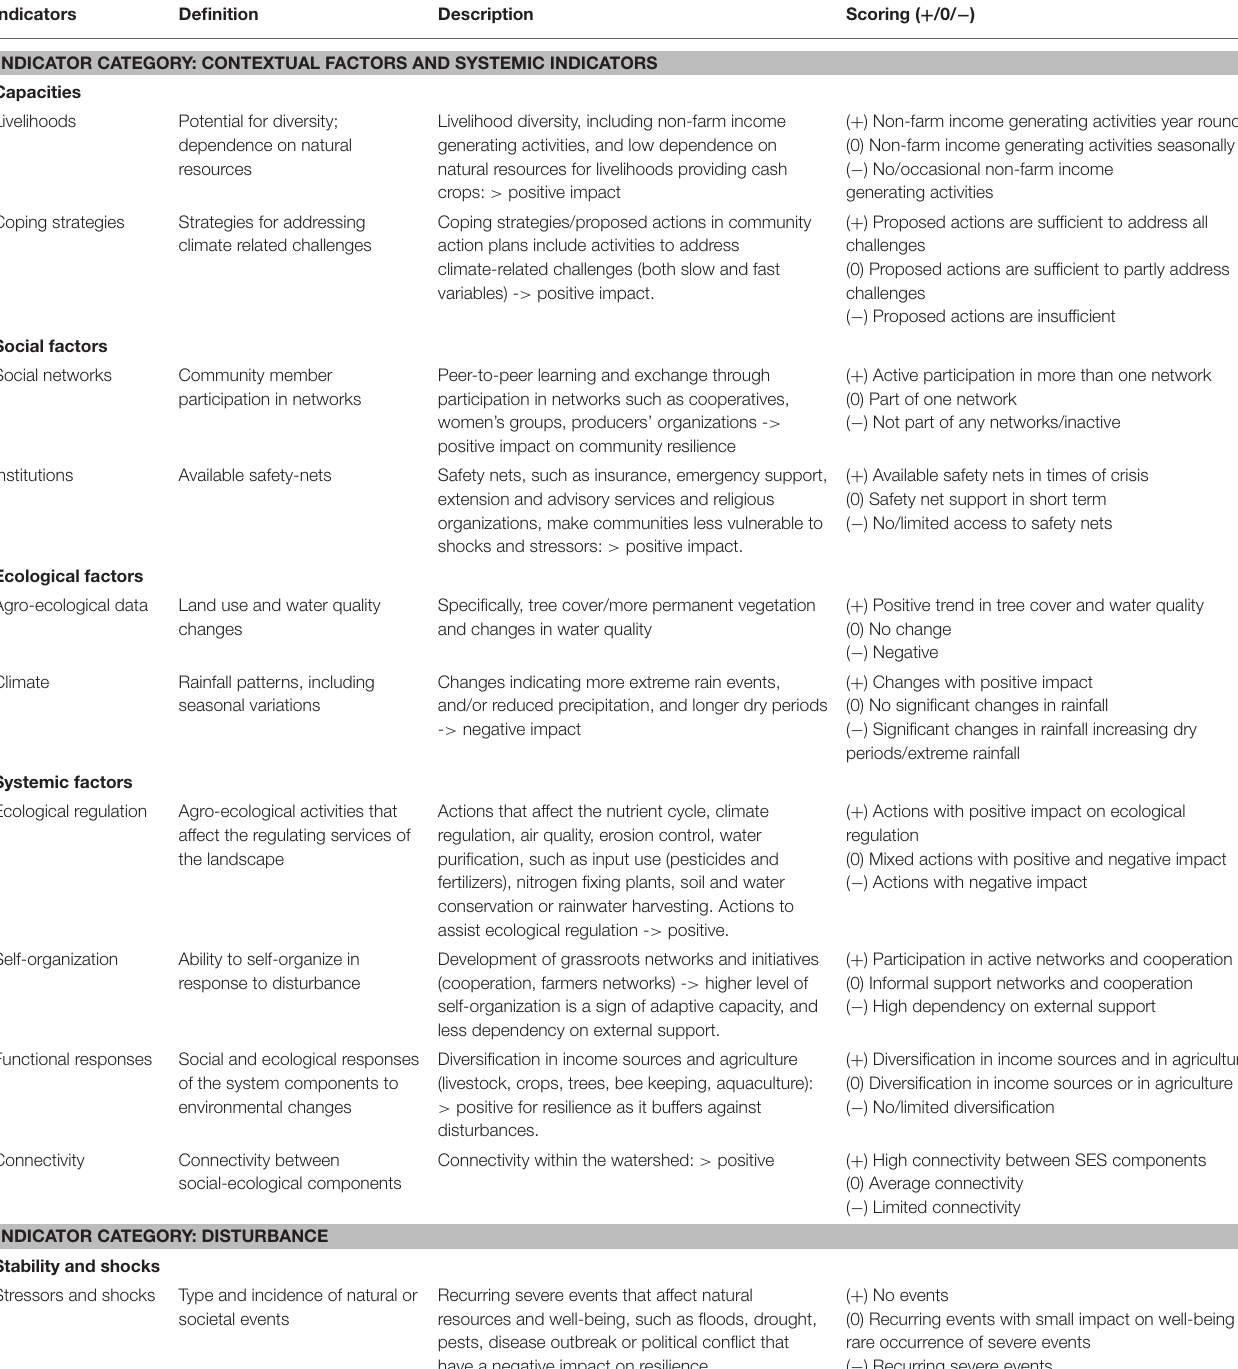
TABLE 3 | Extract indicator category “Contextual and systemic indicators” and “Disturbances” and relative